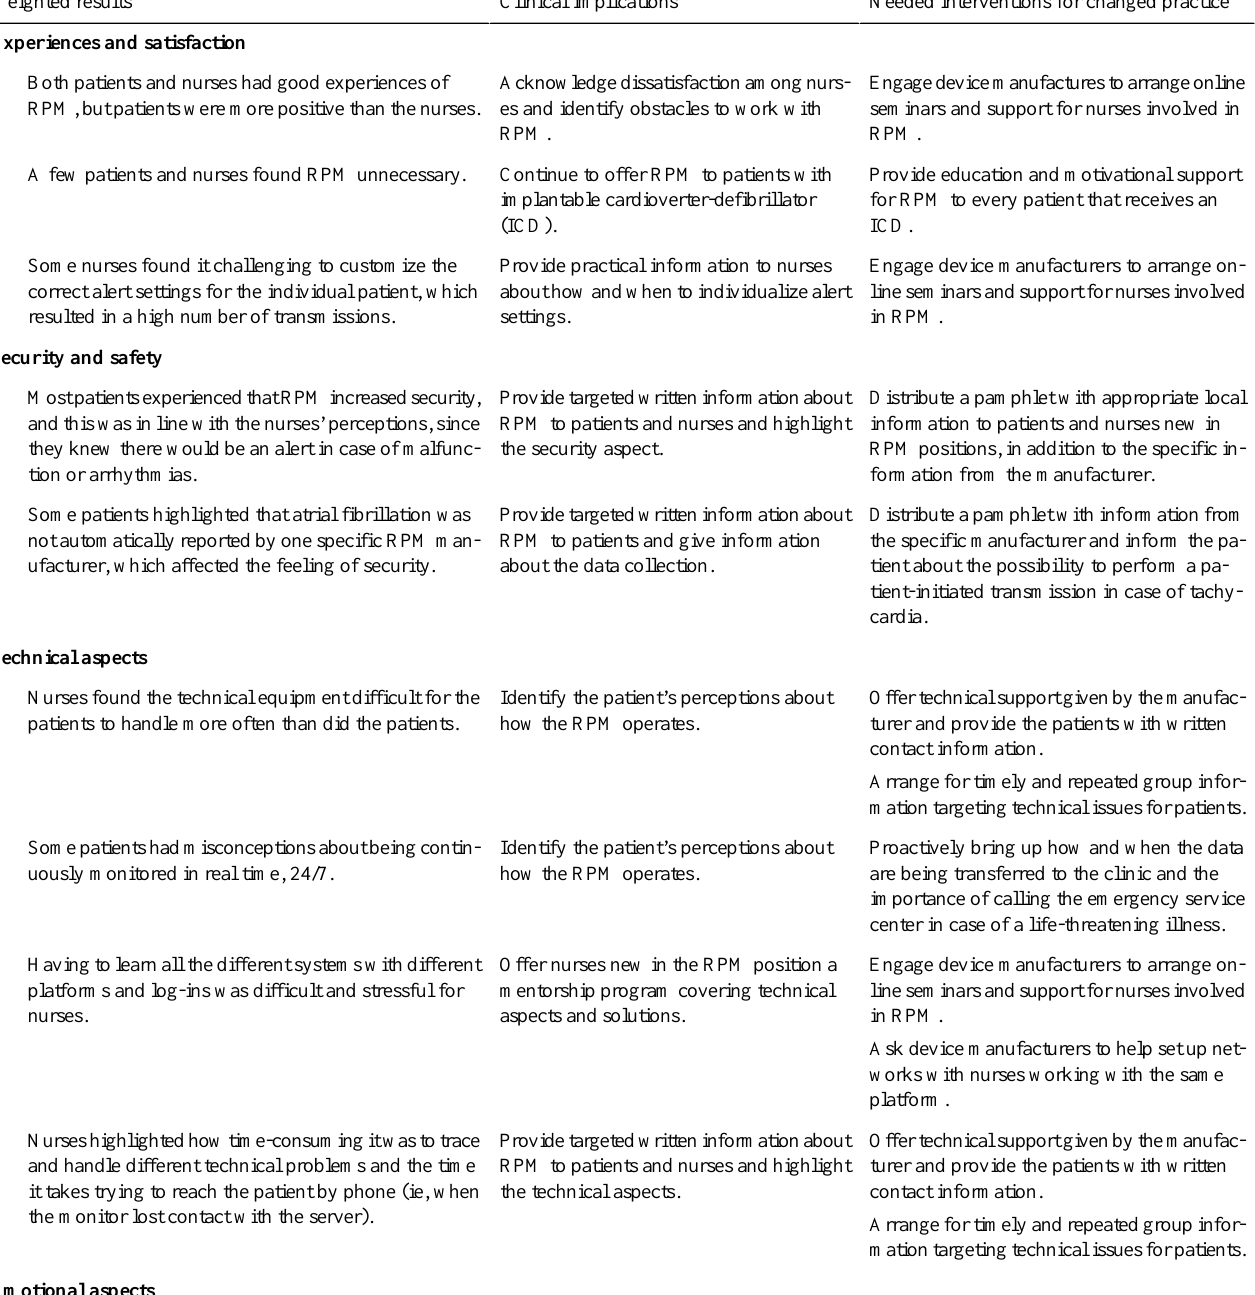
Table 3. Weighted results based on patients’and nurses’experiences of remote patient monitoring (RPM).